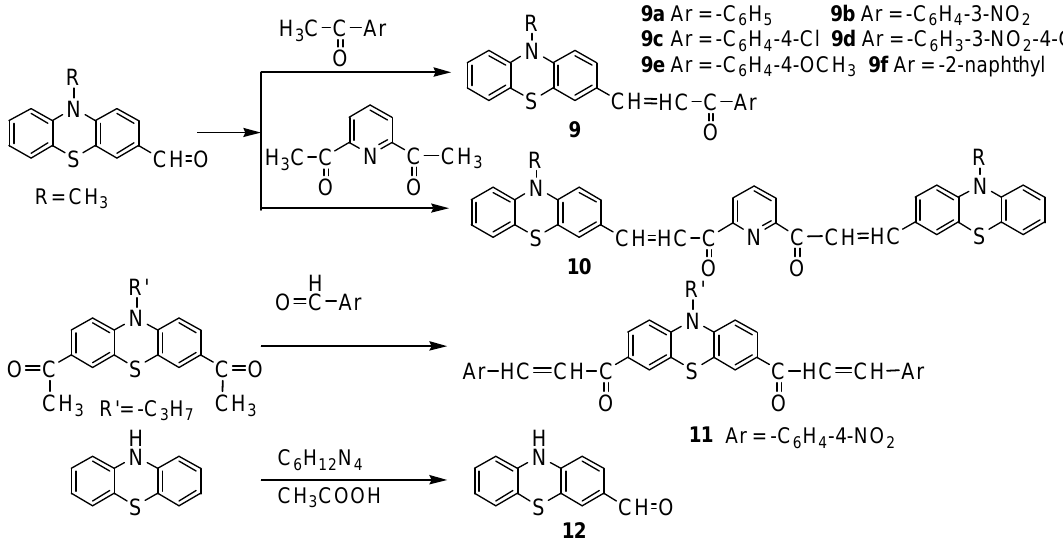
Scheme 2. Chemical reactions for the synthesis of phenothiazine derivatives. Table 2. Preparation of phenothiazine derivatives using a dynamic microwave power system (50%duty cycle, power level 400W). Procedure